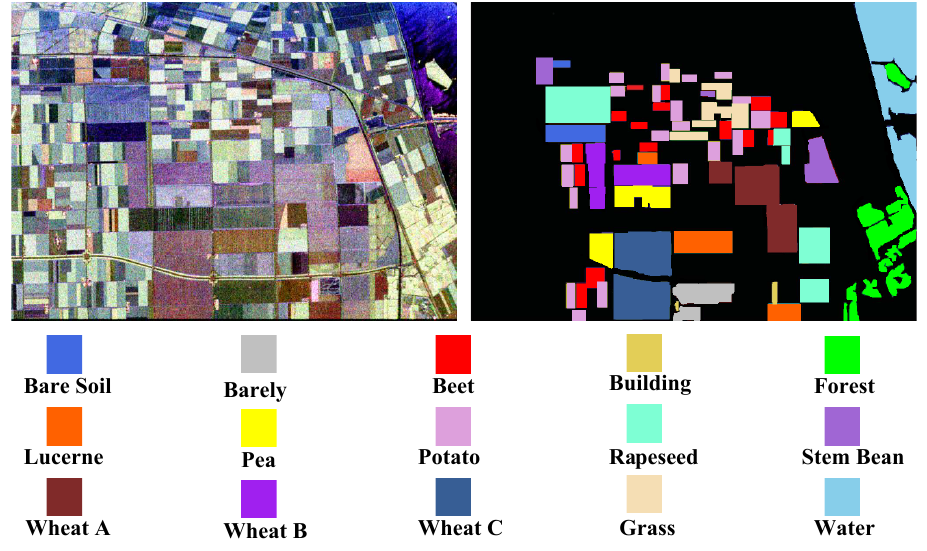
Figure 8. (Left) The false color image of the Flevoland image and (right) the ground truth image, where the black regions are without the accurate class information.